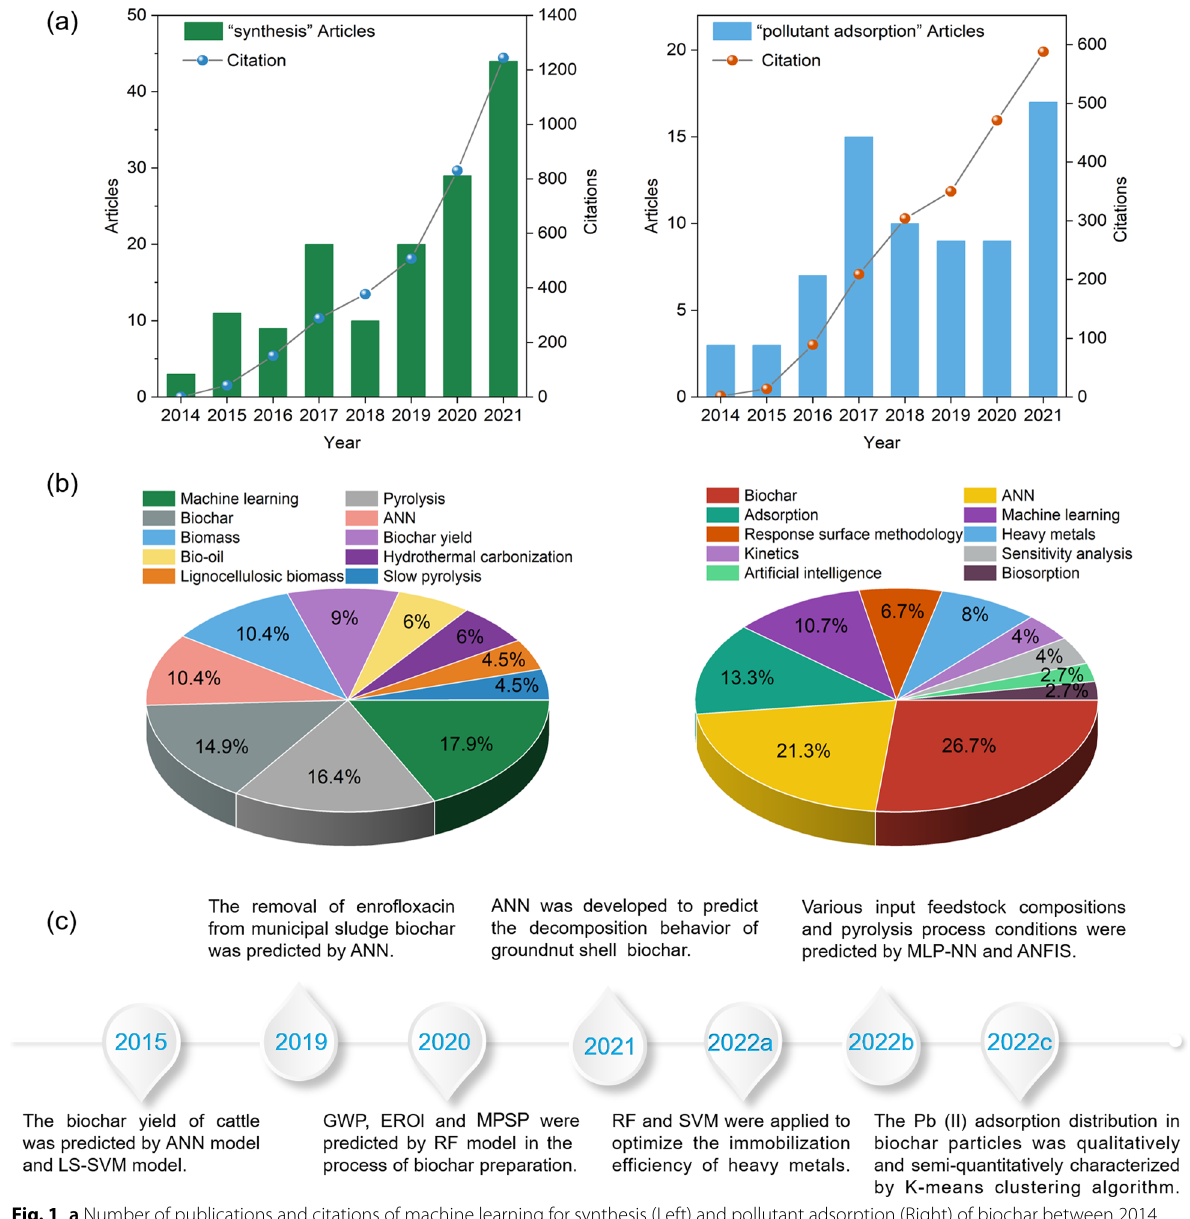
Fig. 1 a Number of publications and citations of machine learning for synthesis (Left) and pollutant adsorption (Right) of biochar between 2014 and 2021 in Web of Science Core Collection; b The frequency of keywords in machine learning for synthesis (Left) and pollutant adsorption (Right) of biochar; c Some milestone events in machine learning for optimizing pyrolysis process and modeling adsorption process of biochar for pollutant removal (Cao et al. 2016; Chowdhury et al. 2019; Hai et al. 2021; Li et al. 2022a; Li et al. 2022c; Palansooriya et al. 2022; Zhang et al.